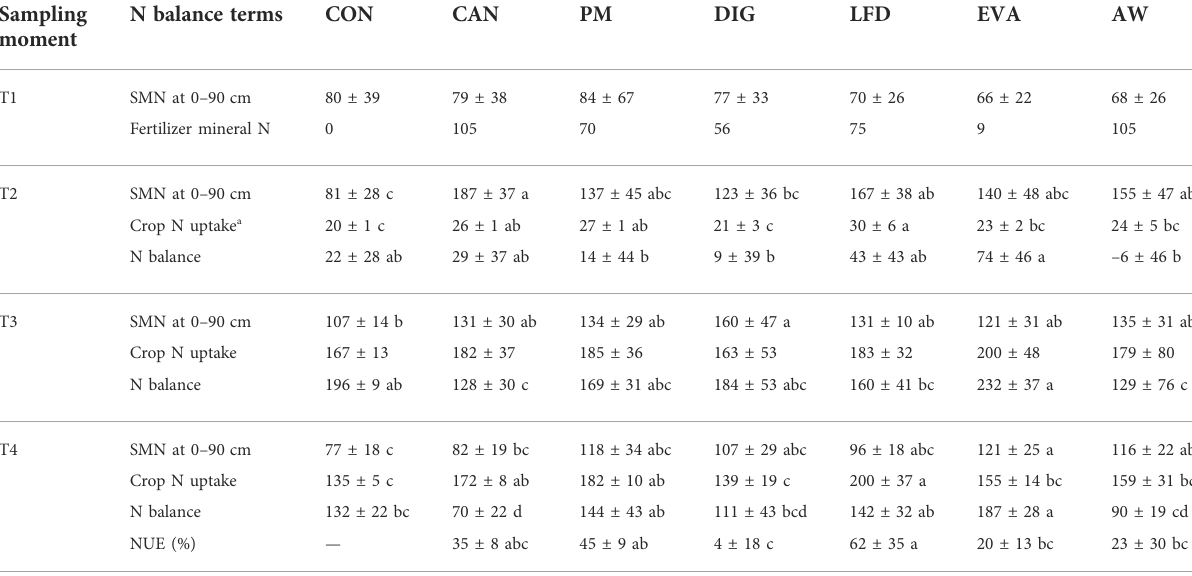
TABLE 3 The terms of the mineral N balance (mean ± standard deviation, kg ha − 1 , n = 4) at sampling moments T1 (8 May 2020), T2 (9 July 2020), T3 (18 August 2020) and T4 (22 September 2020) and the nitrogen use ef fi ciency (NUE, mean ± standard deviation, n = 4) at T4. Sampling